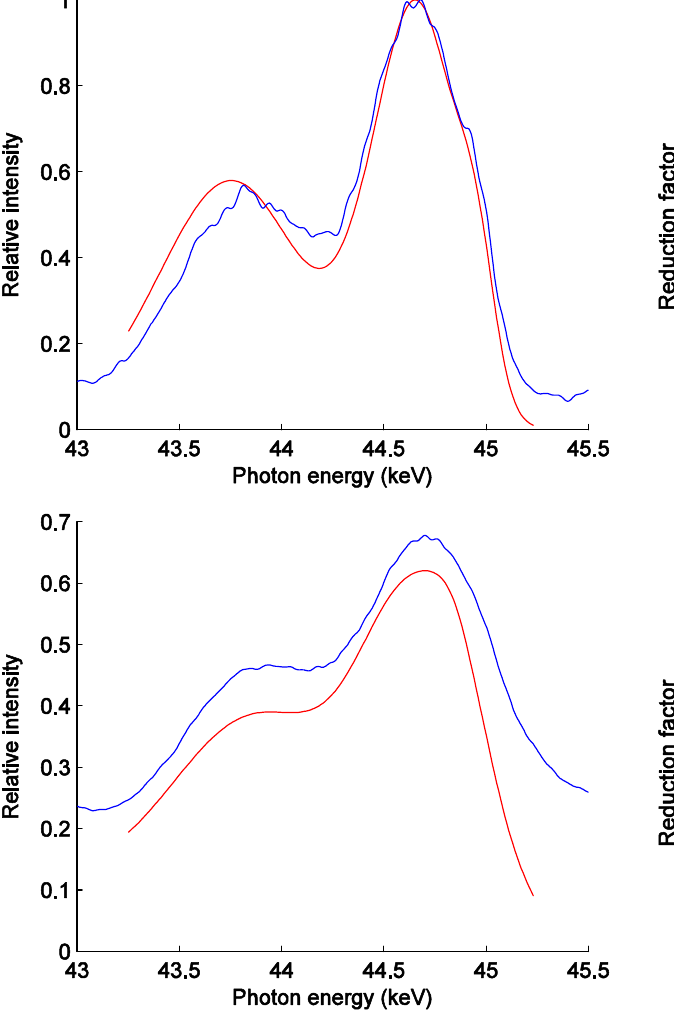
FIG. 18. Flux integrated over a pinhole for the APS high phase error device in the 15th harmonic, including emittance and energy spread. Upper—ideal case without phase errors; lower—with phase errors. Blue curves—calculated with the code UR [18]; red curves—using the current model. Parameters are the same as in Ref. [13]: energy ¼ 7 GeV , rms horizontal/vertical electron beam divergences ¼ 11 : 1 = 4 : 9 (cid:9) rad ,